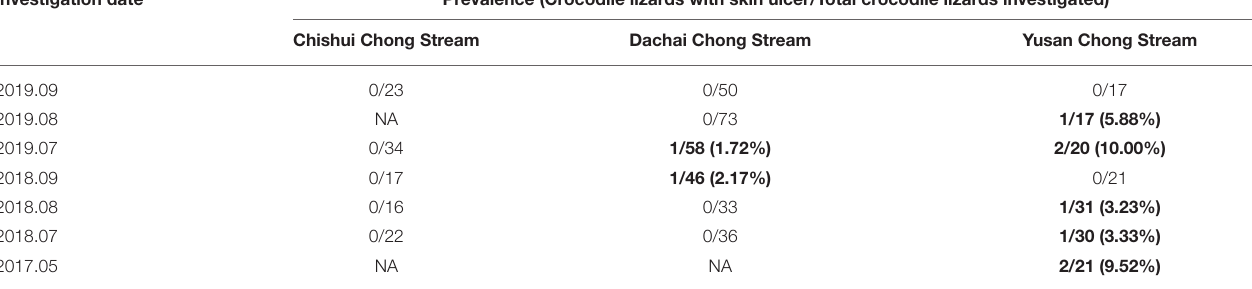
TABLE 1 | Prevalence of skin ulcer in wild crocodile lizards from various